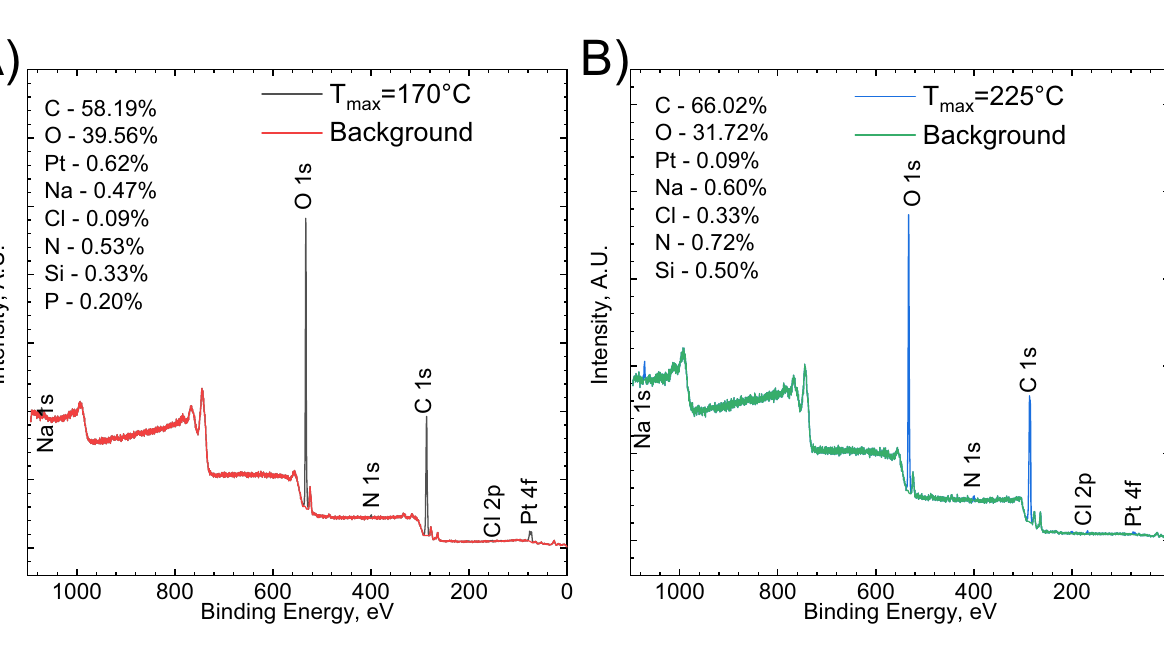
Figure 11. The survey spectra of two samples [Pt(IV)] = 1 × 10 −4 [TSC] = 2 × 10 −3 M: ( A ) T max = 170 °C; ( B ) T max = 225